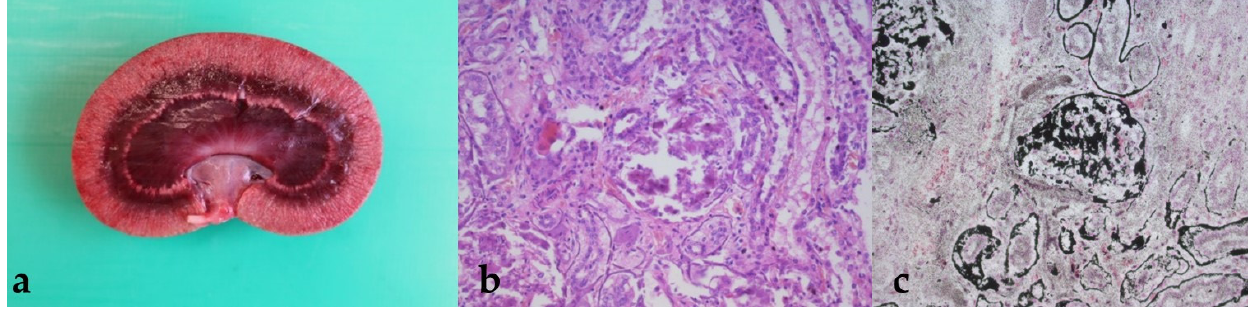
Figure 1. ( a – c ) Kidney. The cortex of the kidney appears brightened with distinct striation and disseminated grayish-white, hard foci of the cortex. Histologically, both glomerular and tubular mineralization are observed (b, H.E. stain; c, von Kossa stain).